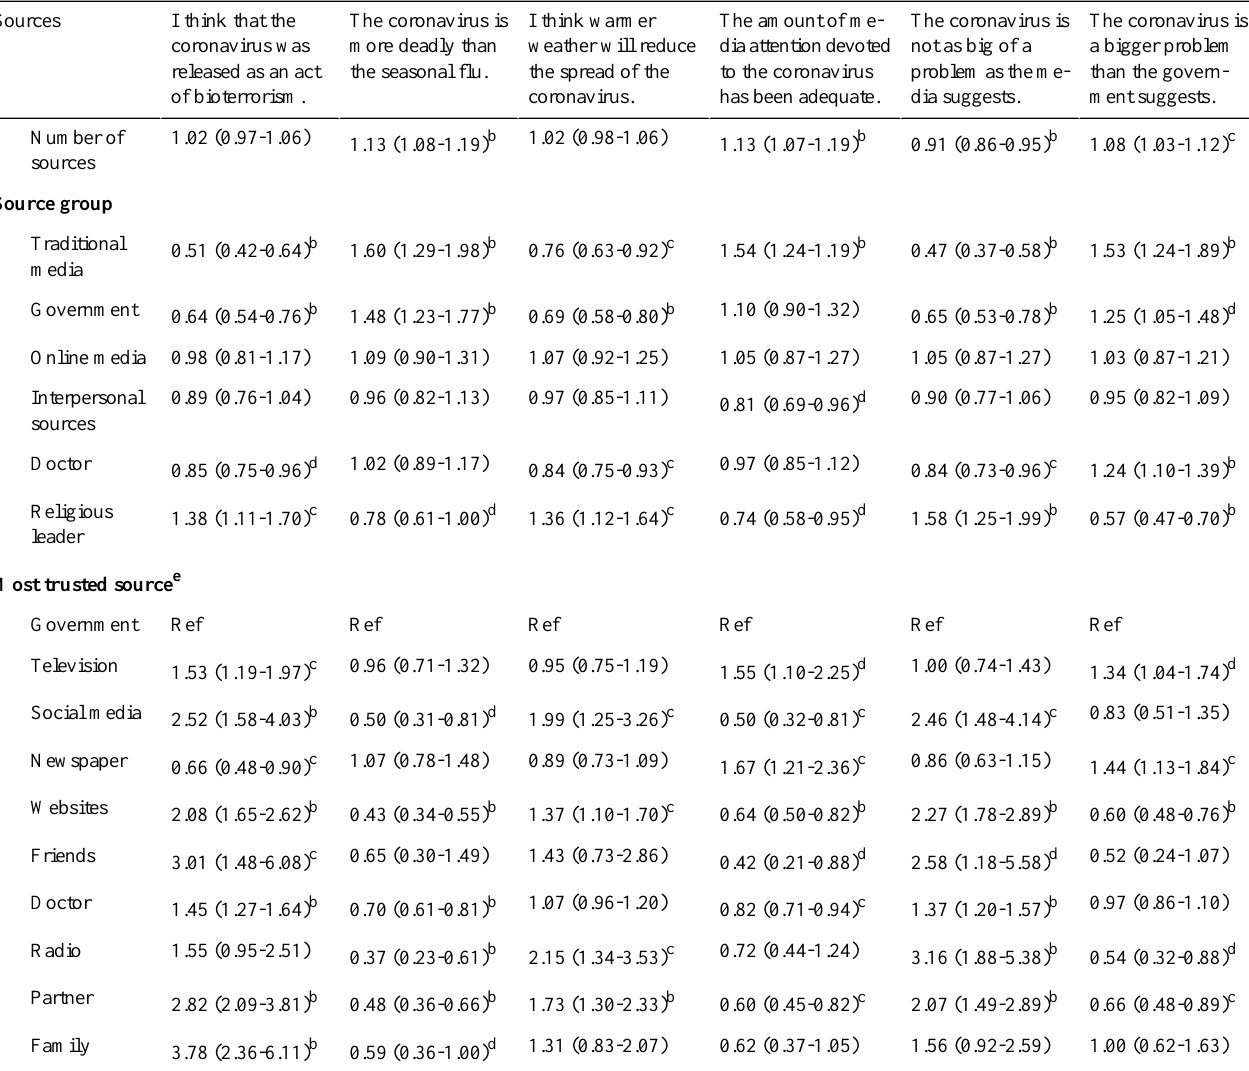
Table 4. Adjusted odds ratios (95% CI) of agreement of COVID-19 beliefs by information source, n=11,242 a . Ref: Reference